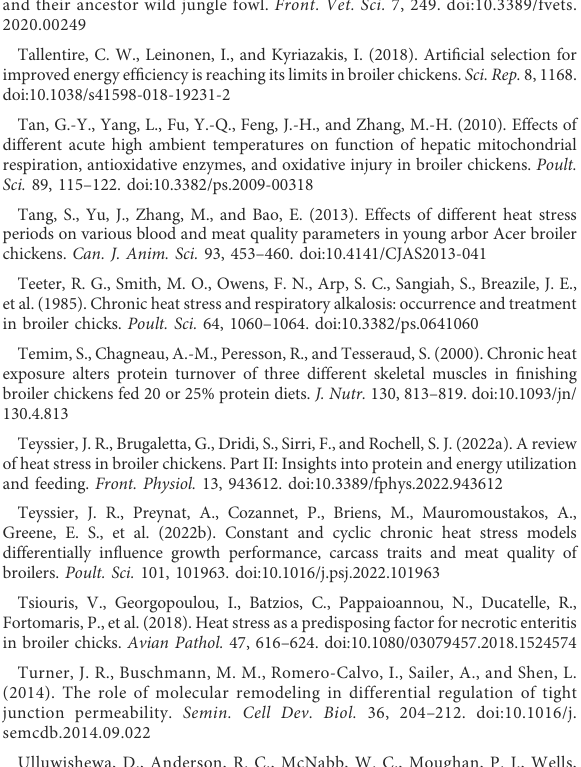
Tabler,T.W.,Greene, E.S.,Orlowski,S.K.,Hiltz,J.Z.,Anthony,N.B.,Dridi, S., et al. (2020). Intestinal barrier integrity in heat-stressed modern broilers and their ancestor wild jungle fowl. Front. Vet. Sci. 7, 249.